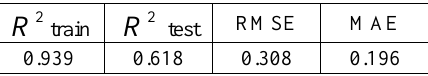
Figure 6 . Results of SVR